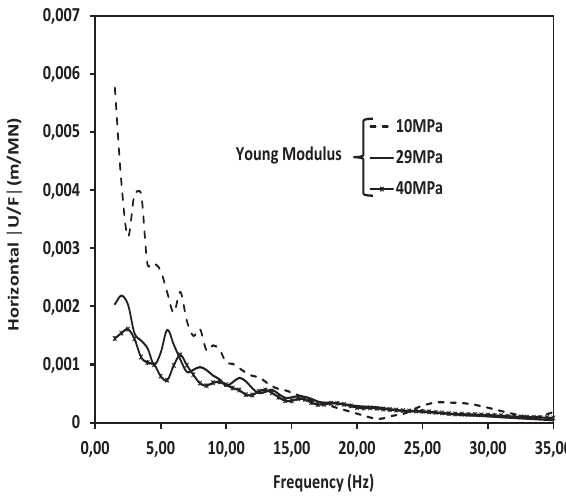
Figure 19: Vertical and horizontal response for the maximum │ U/F │ ̶ Figure 19.Vertical and horizontal response for the maximum │U/F│̶ Influence of the suction module de Influence of the suction module de young